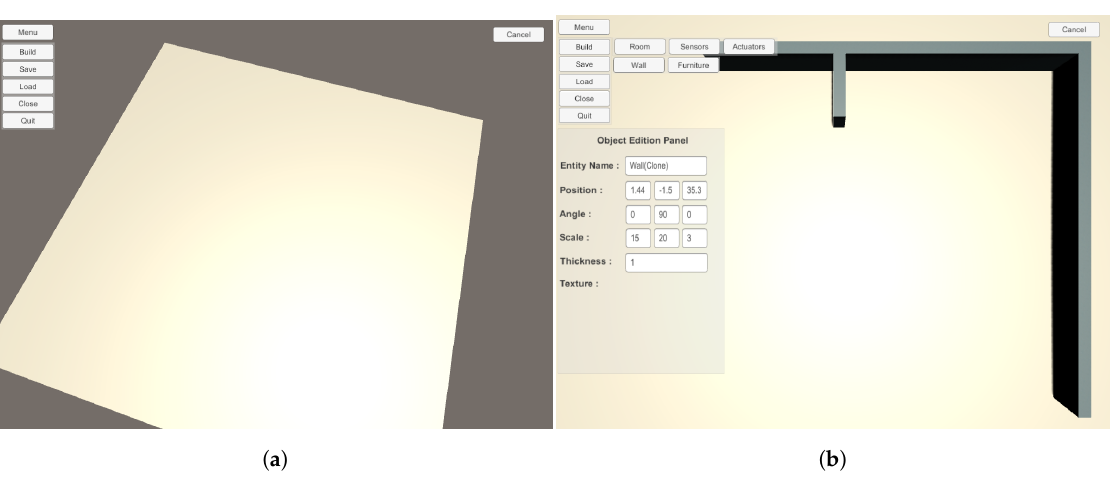
Figure 11. Screenshots of our editor for designing an intelligent environment. ( a ) Empty environment; ( b ) Environment with walls.